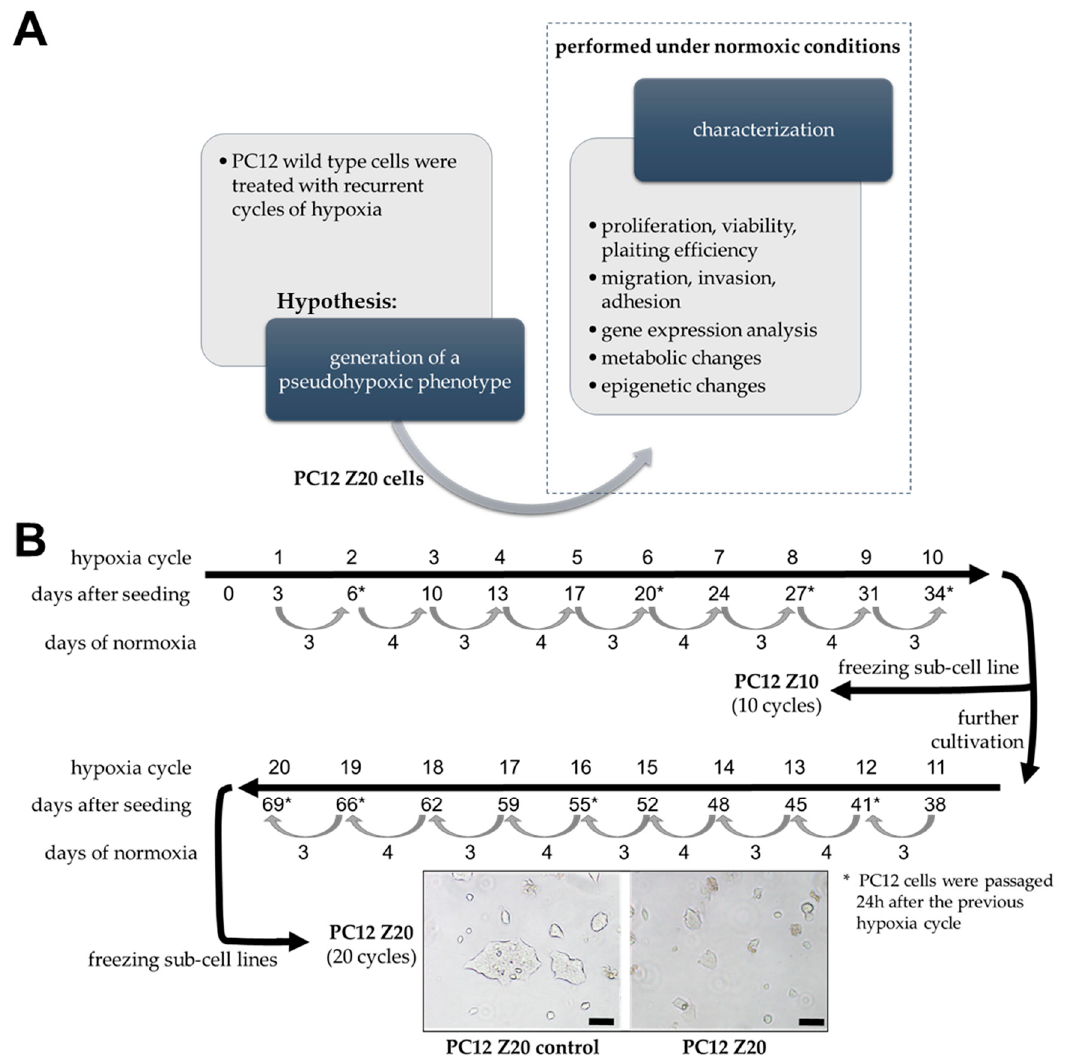
Figure 1. Schematic representation of the experimental procedure. ( A ) The experiments can be divided into two separate parts. First, generation of a sub-cell line by treatment of PC12 cells with recurrent cycles of hypoxia (hypoxia–reoxygenation cycles), based on the hypothesis that this procedure would lead to the generation of a pseudohypoxic phenotype in these cells. In the second part, cells were characterized under normoxic conditions to confirm the pseudohypoxic phenotype of the newly established sub-cell line. ( B ) Procedure to generate PC12 sub-cell lines. Cells were treated with recurring cycles of hypoxia ( ≤ 1% oxygen, 24 h hypoxia/cycle, followed by a reoxygenation phase of 3–4 days). After 20 (PC12 Z20) cycles, morphological changes were determined by phase contrast microcopy in comparison with control cells cultivated under normoxic conditions (PC12 Z20 control). Furthermore, sub-cell lines after 10 hypoxia–reoxygenation cycles were obtained and characterized under normoxic conditions. Scale bar: 100 µm. Unless otherwise stated, all reagents and solutions were of the highest purity from from Gibco (Thermo Fisher Scientific, MA, USA), only fetal calf serum was obtained from Biowest (Riverside, CA,